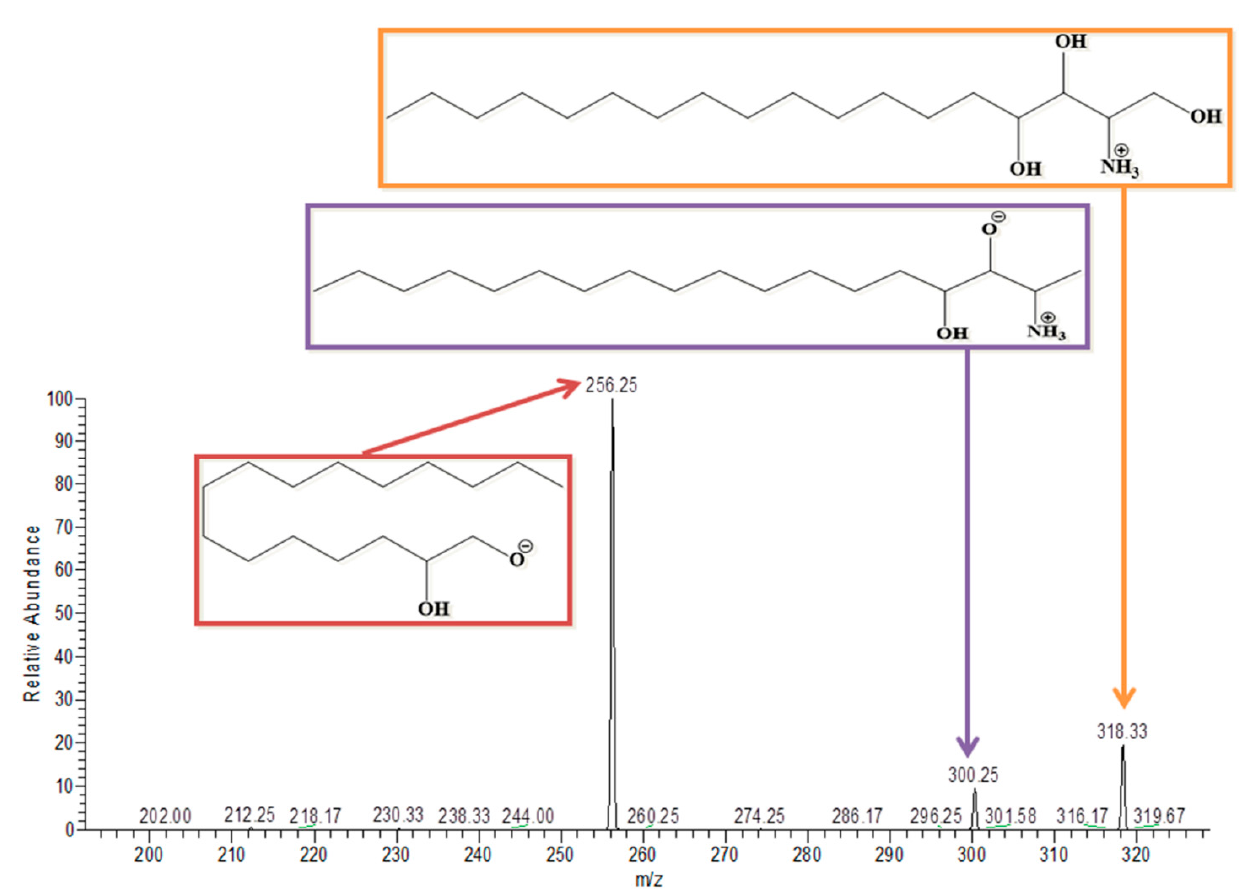
Figure 7. MS/MS spectrum of Phytosphingosine in positive ion mode.